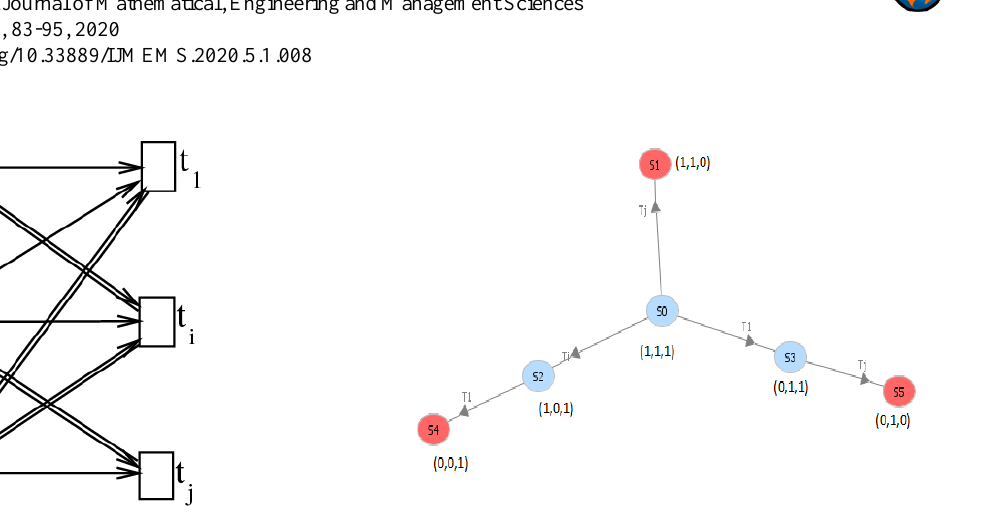
Figure 8. Petri net containing subnet-4 and its coverability